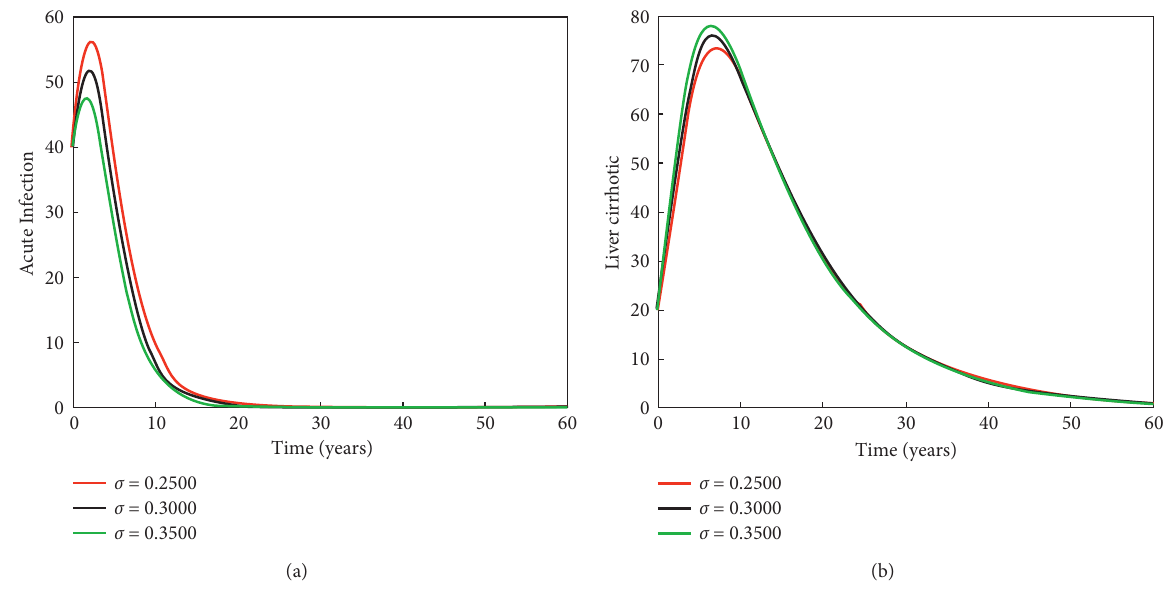
Figure 8: The plot demonstrates the simulation results of acute infection and chronic liver cirrhosis with various progression rate σ .